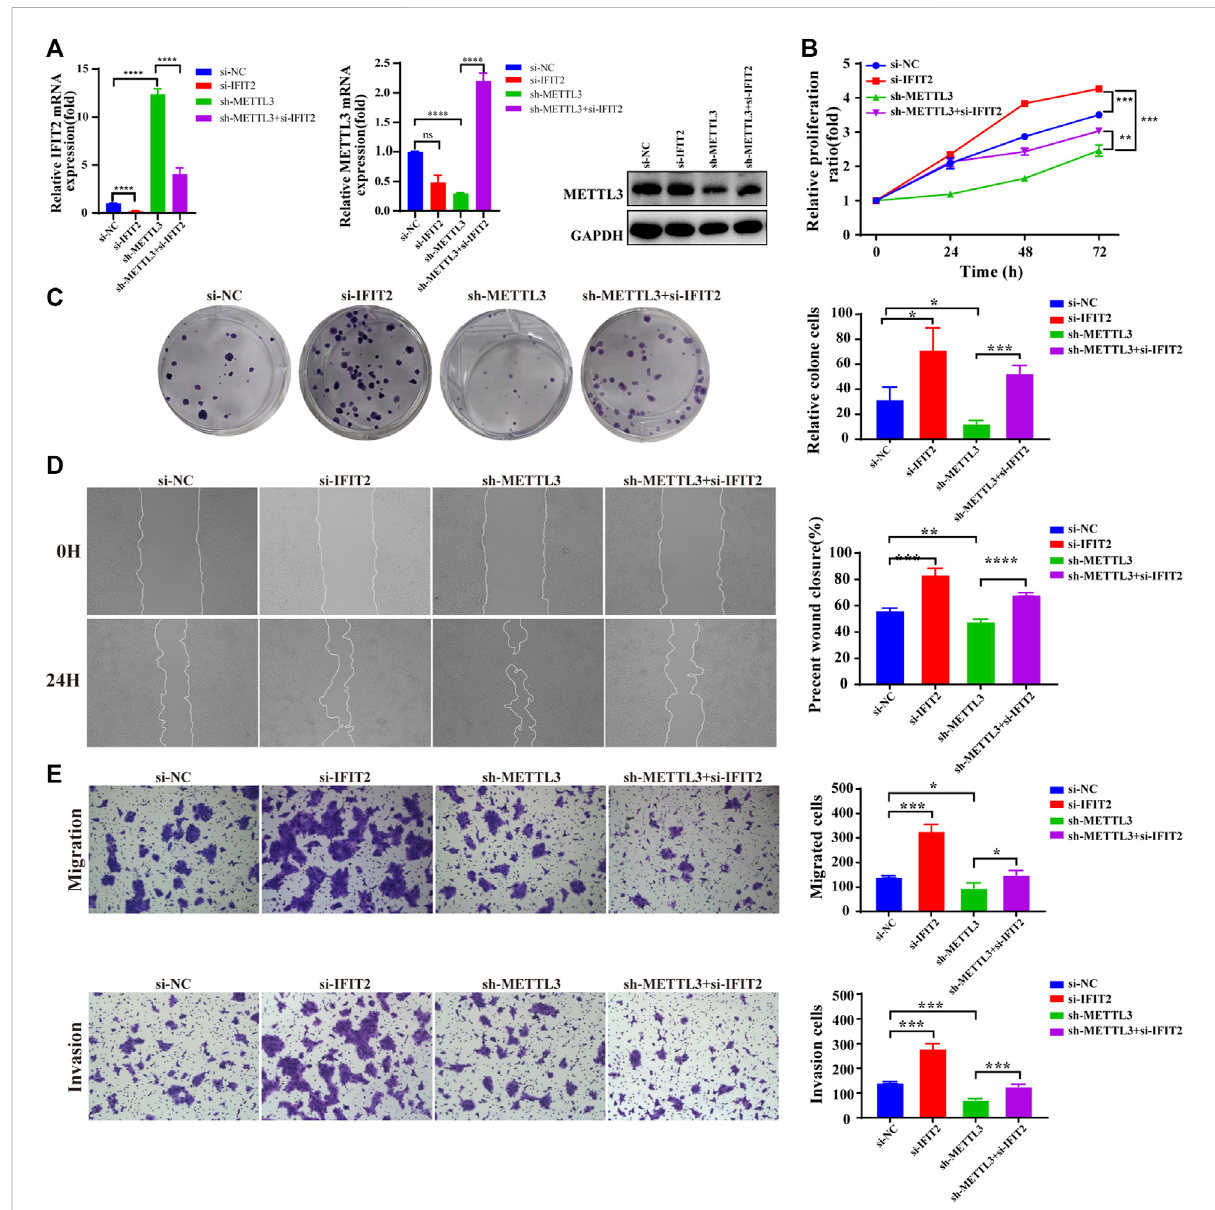
FIGURE 7 METTL3 reverses the biological effects of IFIT2 with respect to ESCC proliferation, invasion and metastasis (A) . Effects of siRNA-IFIT2 on METTL3mRNAandproteinexpressionfollowingMETTL3knockdown. (B,C) .IntheCCK-8andcolonyformationassays,theinhibitionofKYSE150cell proliferation caused by poorly regulated METTL3 was restored by increased regulation of IFIT2 expression. (D) . The wound healing of cells demonstrated that upregulating IFIT2 restored the inhibition of METTL3-induced cell migration. (E) . The transwell migration and invasion tests were successful in rescuing the inhibition of migration and invasion capacity induced by sh-METTL3. n.s, no statistical signi fi cance, * p < 0.05, ** p < 0.01, *** p < 0.001, **** p <